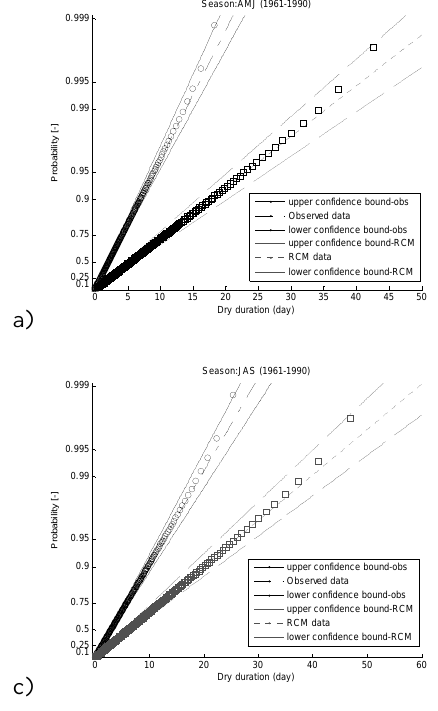
upper confidence bound-obs Observed data lower confidence bound-obs upper confidence bound-RCM RCM data lower confidence bound-RCM